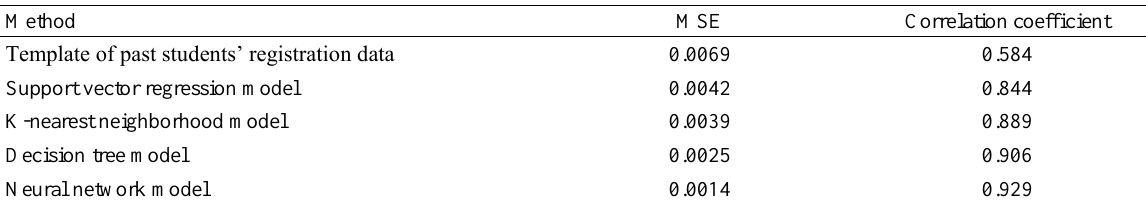
Table 5. Comparison between the performance of different